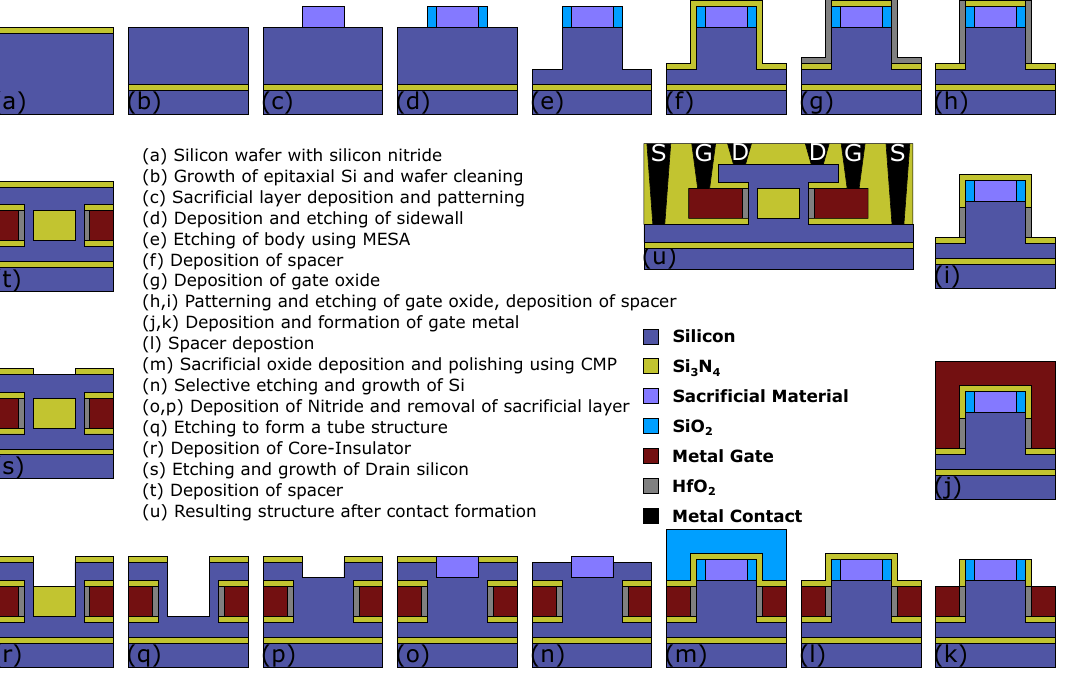
Figure 3. Suggested fabrication process flow for